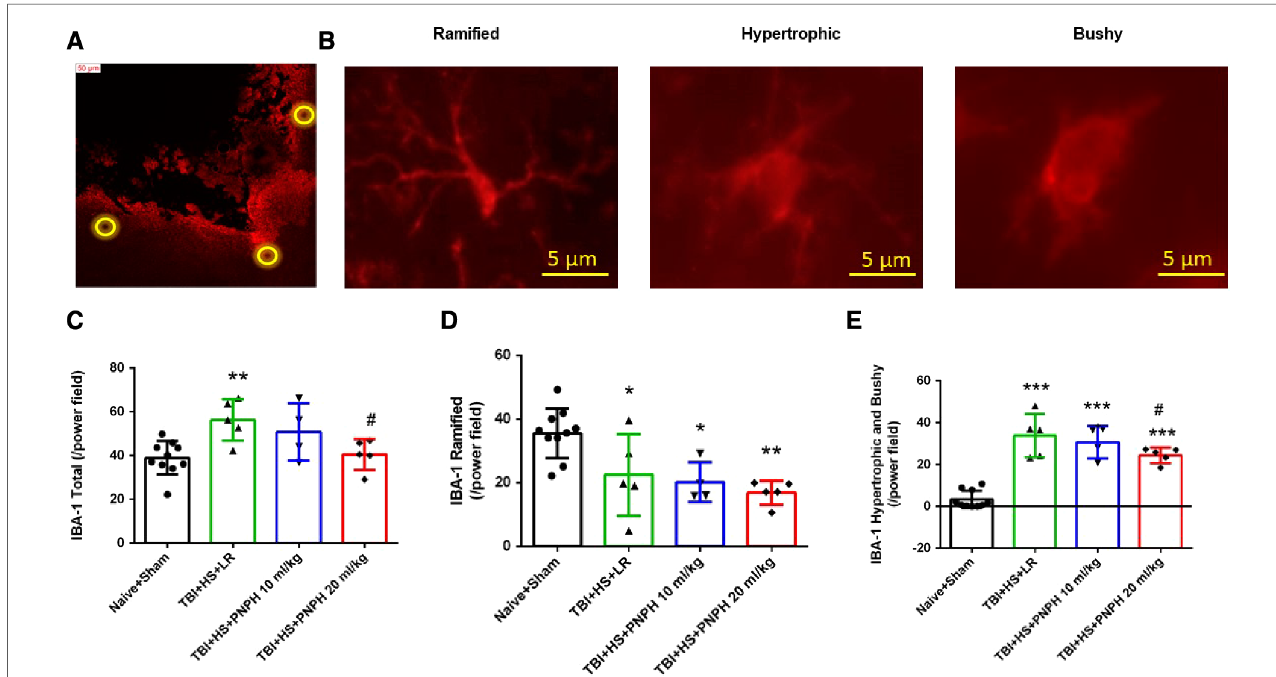
FIGURE 6 Effect of PNPH on microglial activation after TBI+hemorrhagic shock (HS). ( A ) Example of three fi elds selected for counting in the peri-lesion cortex on each side of the contusion and near the inner depth of the contusion. ( B ) Representative images of three morphologies of microglial cells: rami fi ed, hypertrophic, and bushy. The number of Iba-1 – positive cells ( C ), rami fi ed Iba-1 – positive cells ( D ), and hypertrophic plus bushy Iba-1 – positive cells ( E ) are plotted for the combined Naïve+Sham group ( n =10) and for TBI+HS groups resuscitated with 60 ml/kg lactated Ringer ’ s (LR) solution ( n =5), 10 ml/kg PNPH ( n =4), and 20 ml/kg PNPH ( n =5). The dose of 20 ml/kg PNPH attenuated the increased in microglia density and the number of hypertrophic/bushy microglia. Mean±SD and individual data for each pig are shown. * P <0.05, ** P <0.01, *** P <0.001 vs. combined Naïve and Sham groups; # P <0.05 vs. LR group determined by one-way ANOVA and the Holm-Sidak procedure for multiple